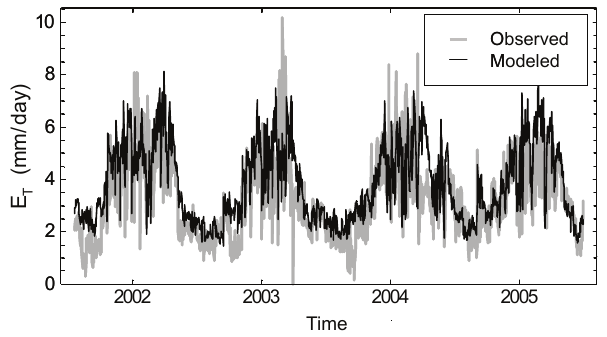
Fig. 2. Result of an optimality based modeling framework (from Schymanski et al., 2009b): observed and modeled daily evapo- transpiration rates. The model simulates the vegetation that opti- mizes the net carbon profit given an observed semi-arid climate in